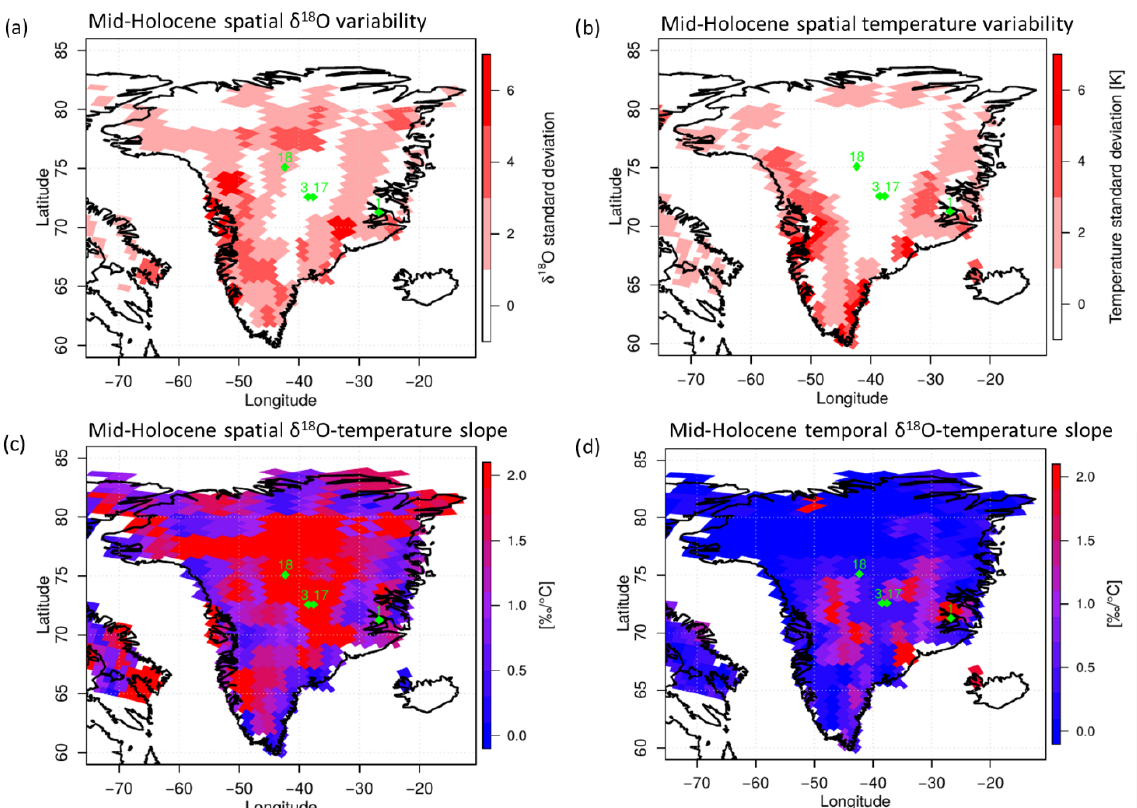
Figure 9. The same as Fig. 7 but for the mid-Holocene. The locations of the ice core samples are shown in green.